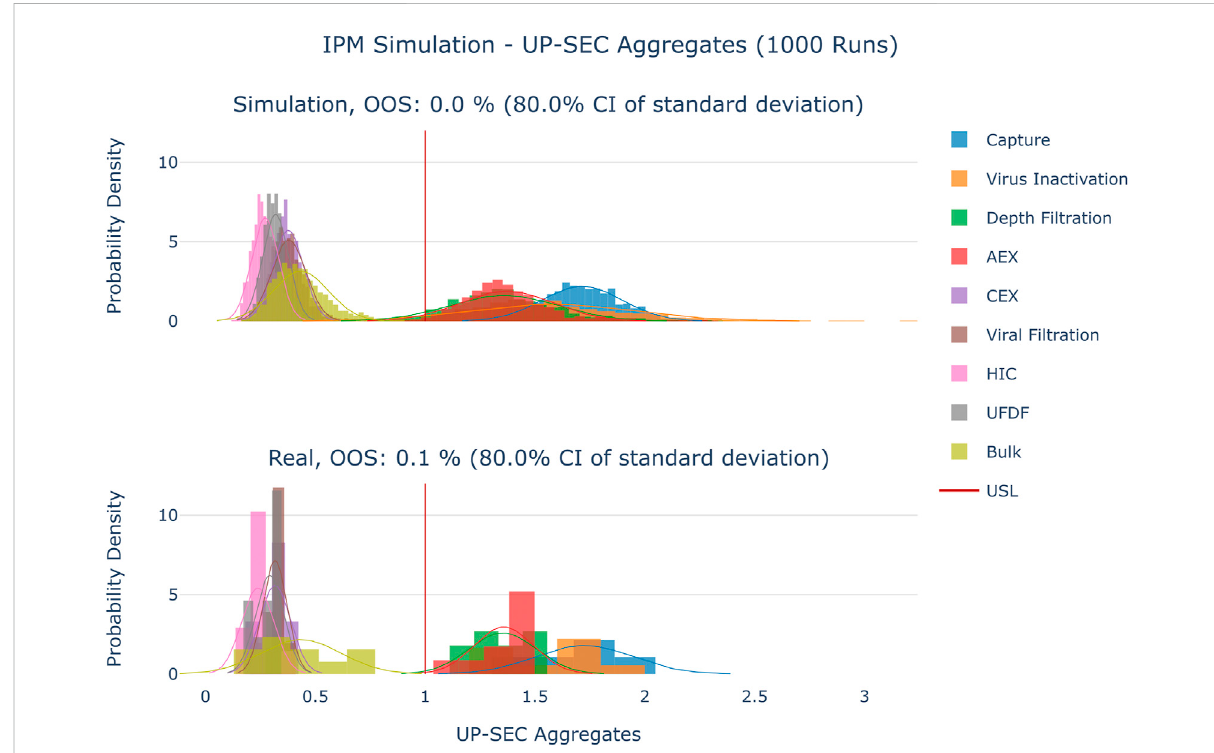
FIGURE 5 Comparison of distributions of the simulation to 10 large scale manufacturing runs for the CQA UP-SEC Aggregates. The upper plot shows the simulated data based on 1000 simulations performed at set-point conditions. The lower plot shows the data from 9 large scale